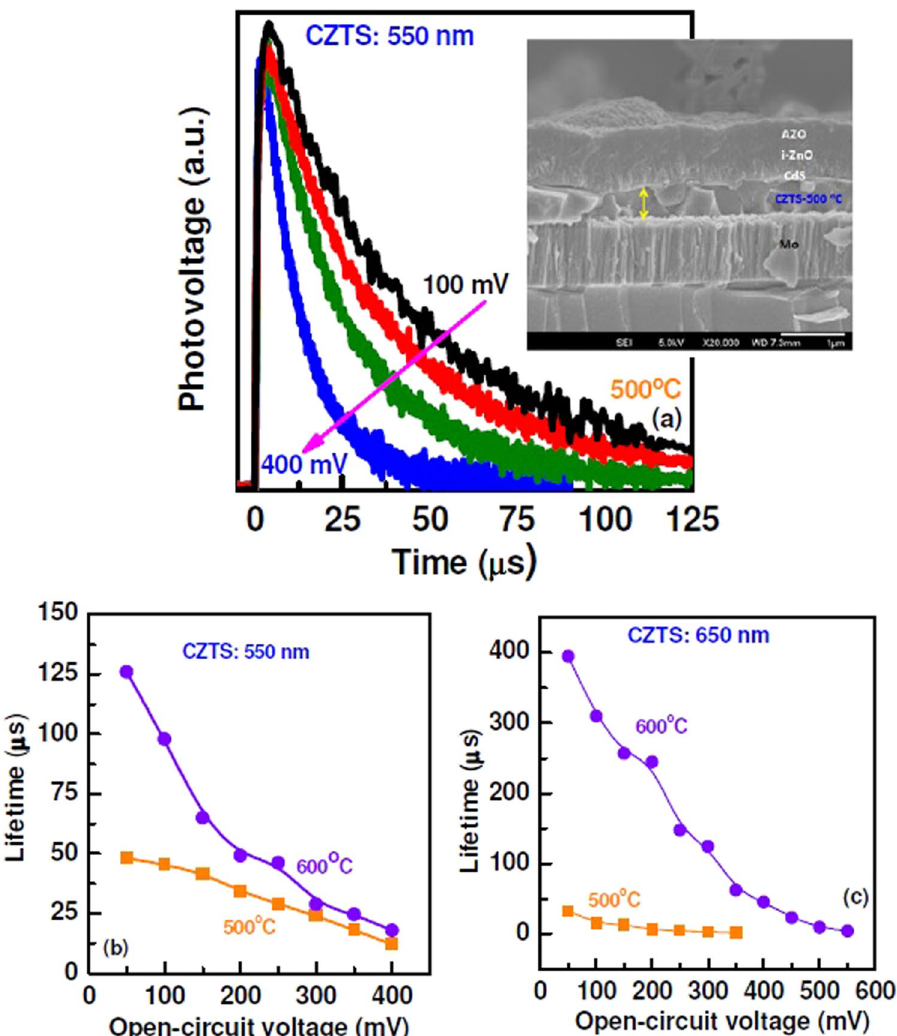
Figure 3. ( a ) Transient photovoltage characteristics of CZTS/CdS junction with 550 nm thick CZTS layer sulphurized at 500 °C. Carrier life time characteristics of the solar cell with CZTS thickness of ( b ) 550 nm and ( c ) 650 nm after sulphurized at 500 °C and 600